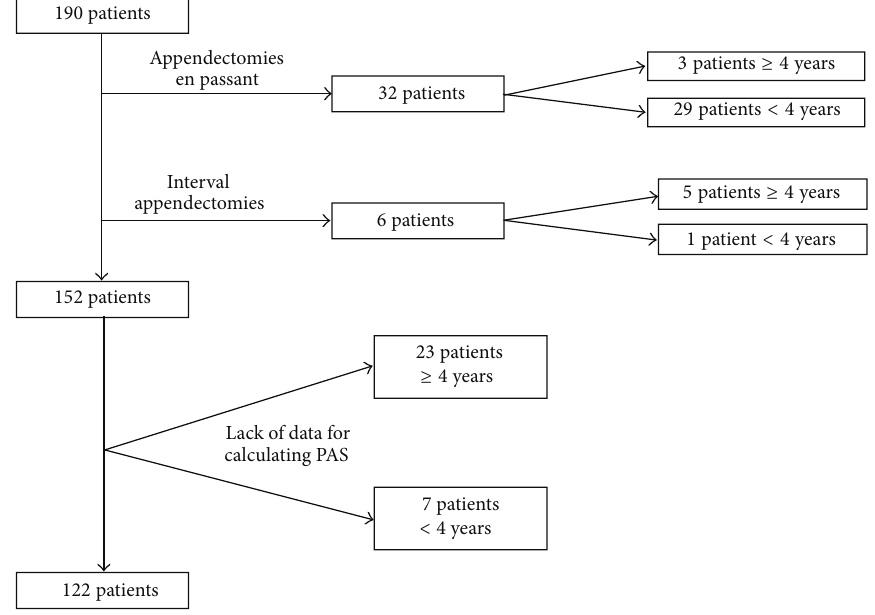
Figure 1: Flow chart of patient recruitment.